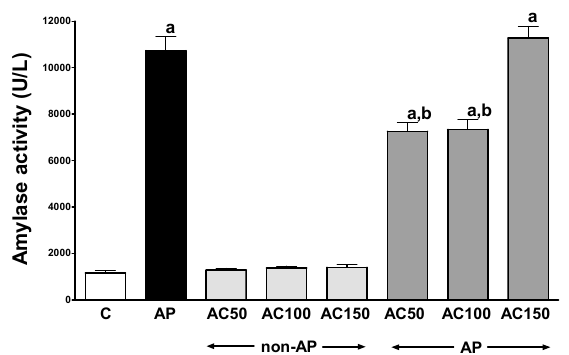
Figure 7. Impact of pretreatment with acenocoumarol on serum activity of amylase in rats with or without cerulein-induced pancreatitis. Key: C = control; AP = cerulein-induced acute pancreatitis; non-AP = groups without induction of acute pancreatitis; AC = acenocoumarol; 50 = 50 µg/kg/day; 100 = 100 µg/kg/day; 150 = 150 µg/kg/day. Mean ± SEM. n = 10 in each group of rats. a p < 0.05 compared to control; b p < 0.05 compared to AP alone.